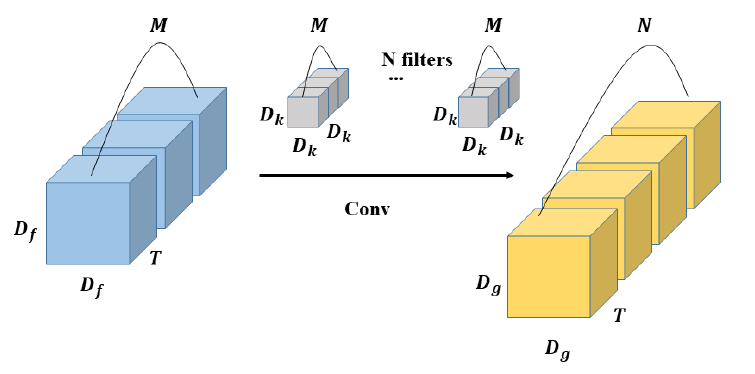
Figure 6. The process of standard 3D